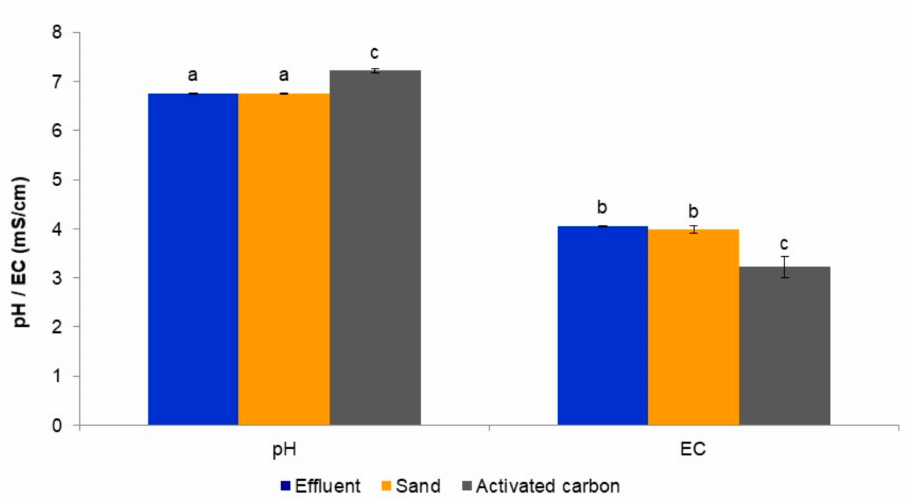
Figure 3. The pH and electrical conductivity (EC) changes during processing of the biologically treated fungicide-containing effluent through the sand filter and the activated carbon adsorption column system. For each parameter, bars designated by the same letter are not significantly different at the 5%